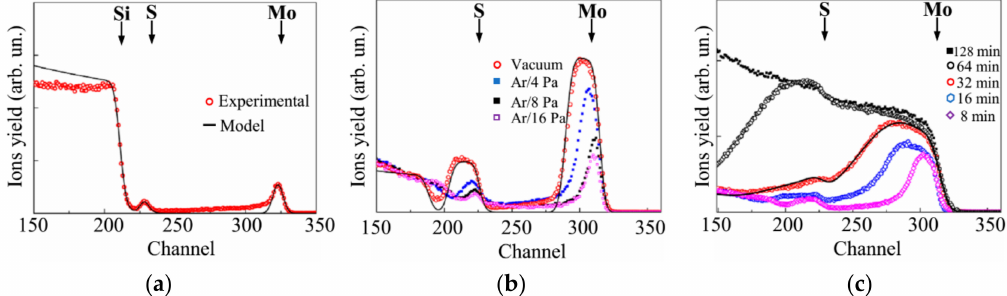
Figure 3. Rutherford backscattering spectroscopy (RBS) spectra for MoS x ~2 + δ / Mo films obtained by on-axis pulsed laser deposition (PLD) on the Si and Si / SiO 2 substrates. ( a ) A thin film deposited for 1 min on the Si substrate. ( b ) Films of middle thickness deposited on the Si / SiO 2 substrates for 4 min in a vacuum and at di ff erent Ar pressures. ( c ) Thicker films deposited on the Si / SiO 2 substrate in Ar at a pressure of 8 Pa for various deposition times. The solid lines indicate the model / fitted RBS spectra for the corresponding experimental spectra. The arrows indicate the channels of accumulation of He ions which were back scattered by Mo, S, and Si atoms located on the surface of the